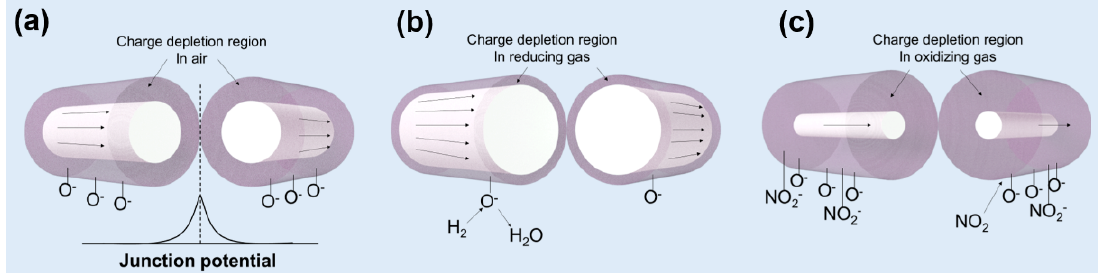
Figure 24. A schematic diagram of conventional nanowire–nanowire junction sensors: ( a ) nanowire conducting channel exposed to ambient; ( b ) nanowire conducting channel exposed to oxidization gas; and ( c ) nanowire conducting channel exposed to reducing